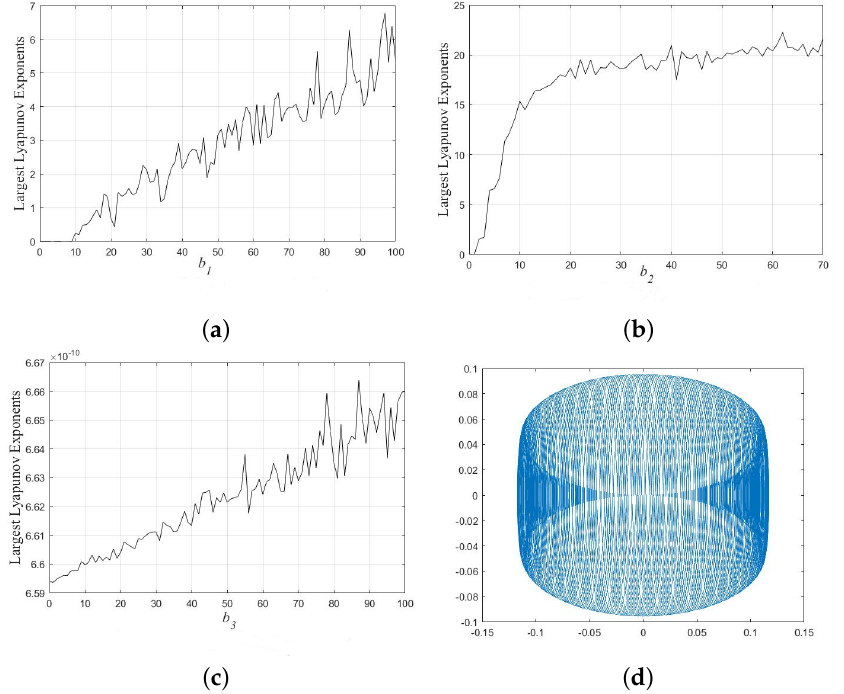
Figure 6. System (18): ( a ) largest Lyapunov Exponents for b 1 ; ( b ) largest Lyapunov Exponents for b 2 ; ( c ) largest Lyapunov Exponents for b 3 ; ( d ) Phase portrait, when b 1 = − 0.22, b 2 = − 0.233, b 3 = − 0.759, b 4 = − 0.178, R 2 ( ξ ) = sin ( 10 ξ ) .